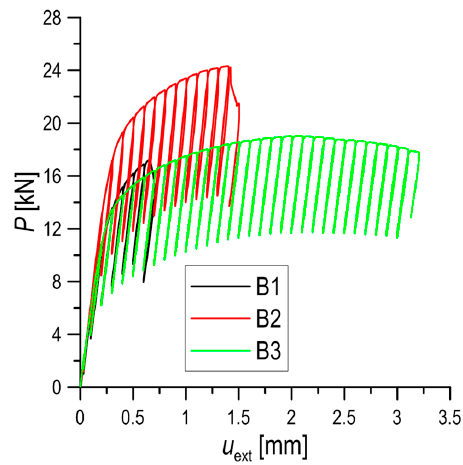
Figure 8. Force-displacement diagram for welded joint tests for unmodified cast steel (B series).